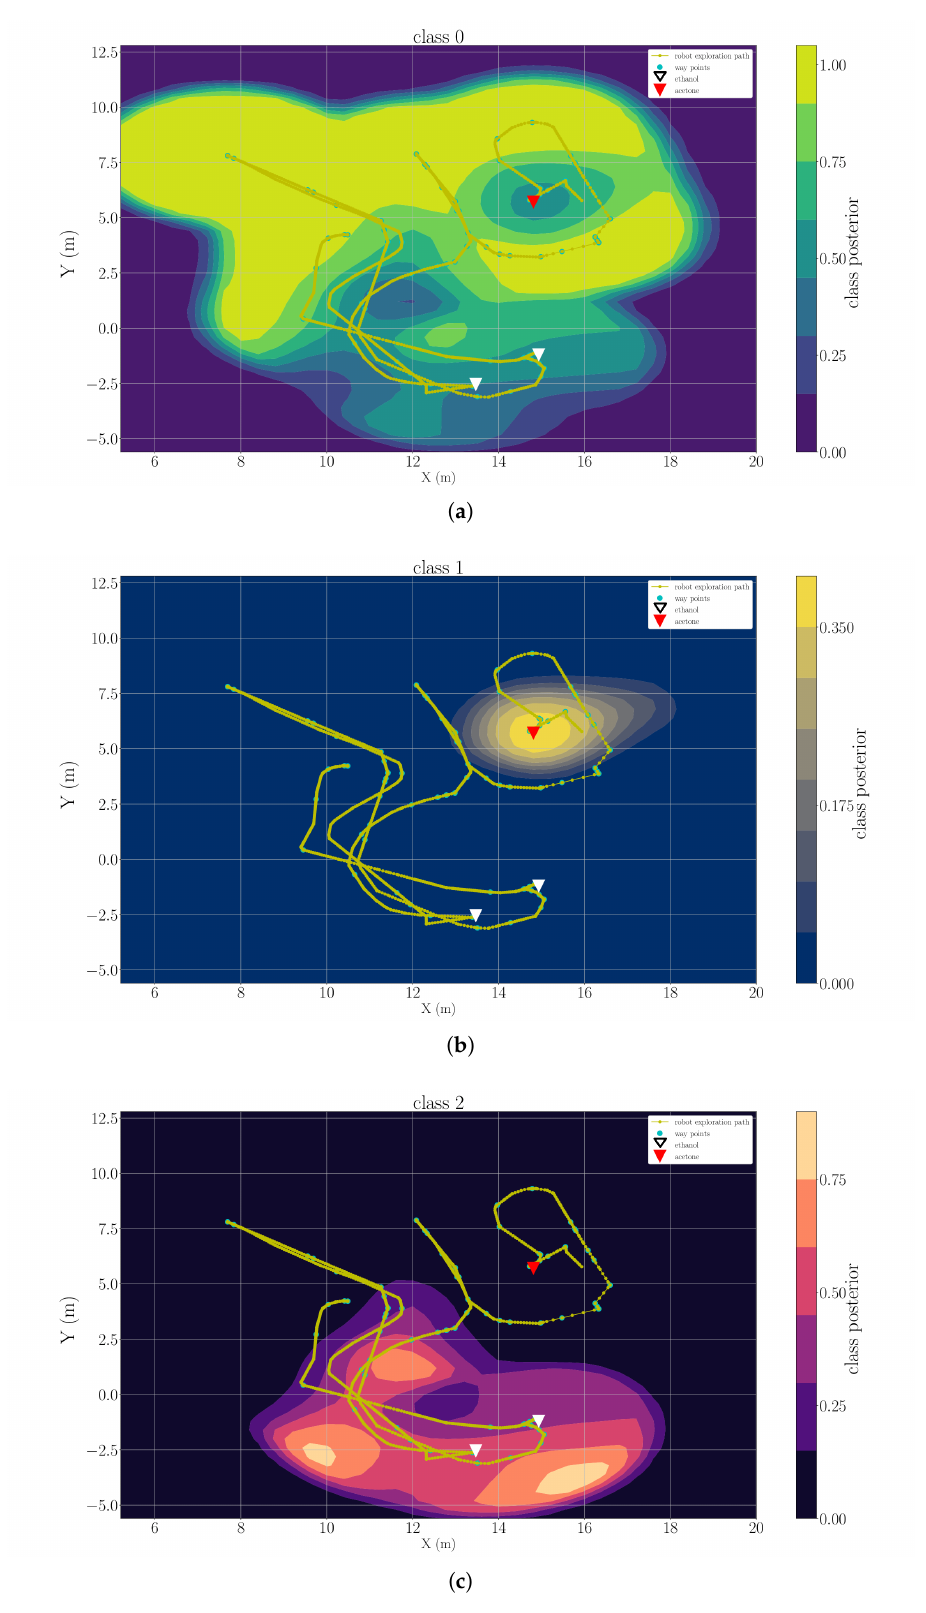
Figure 13. A snapshot of the classification map learned for clean air ( a ), ethanol ( b ) and acetone ( c ) in the trial Experiment